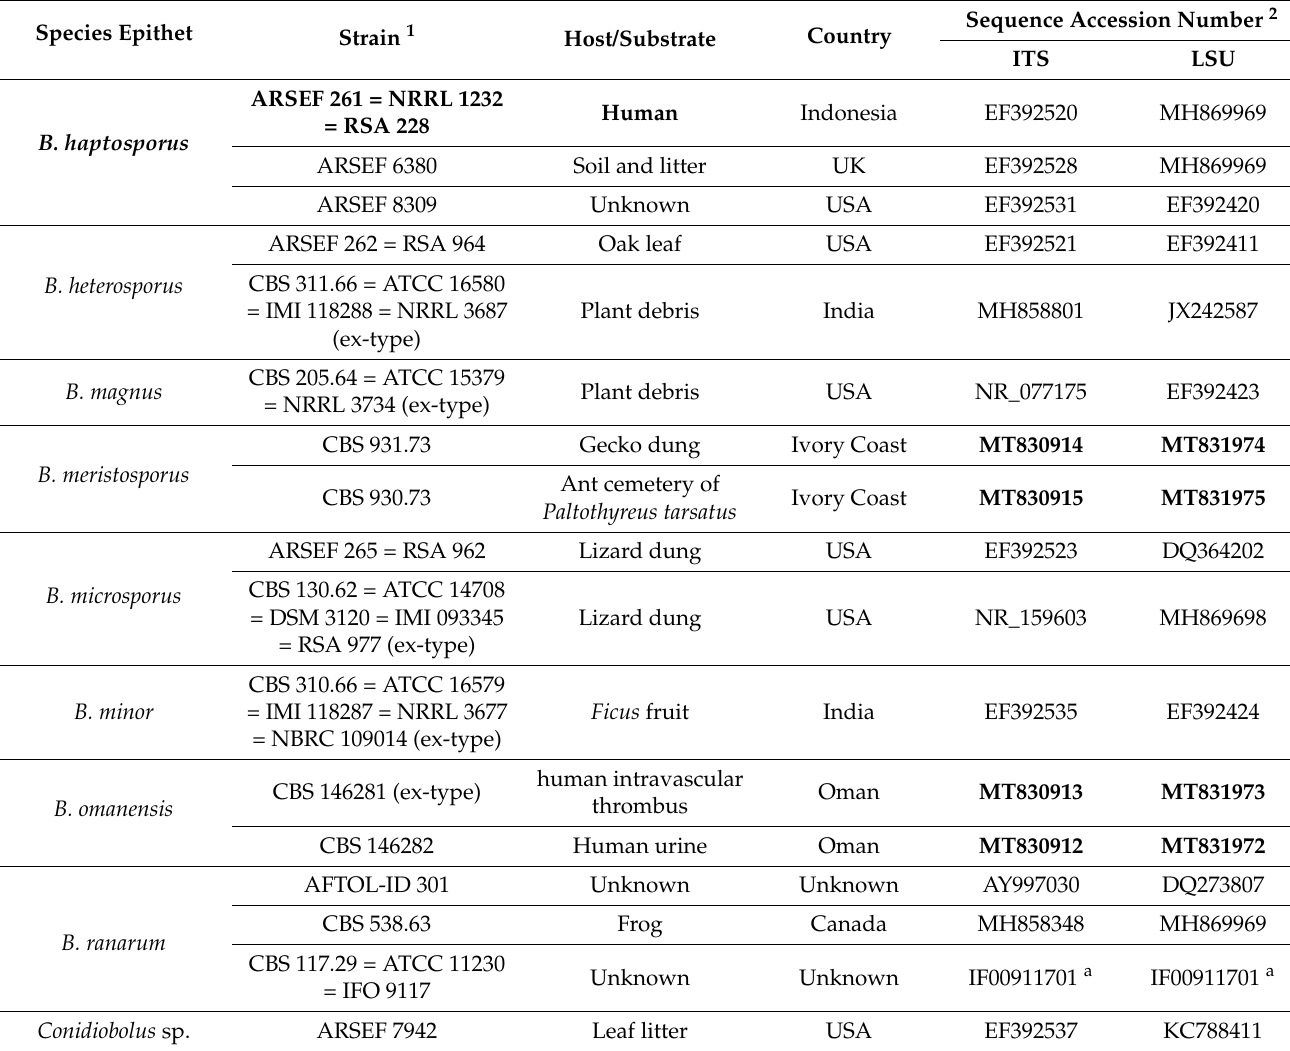
Table 1. Strain information and accession numbers of DNA sequences included in the phylogenetic